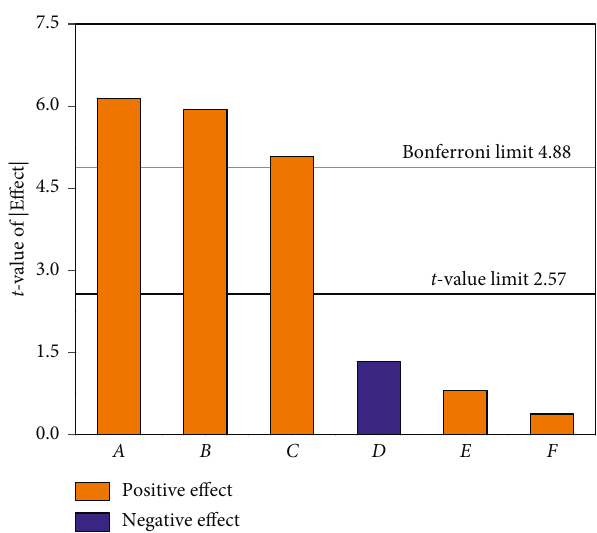
Figure 1: Estimated variable effects on the saponins extraction yields in the Plackett–Burman design. Pareto chart of the six variables’ effects on saponins